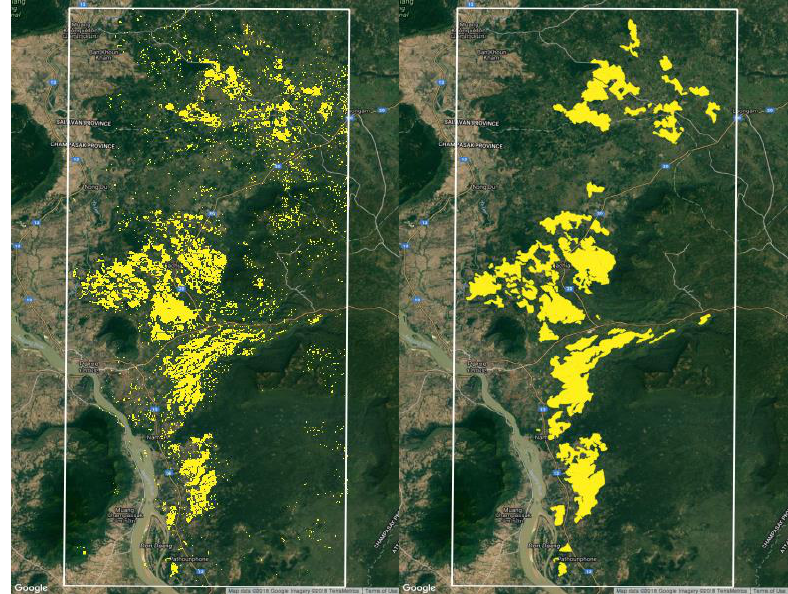
Figure 4. Rubber planted areas in southern Laos mapped from satellite data. The map on the left was produced by hand digitizing the plantation boundaries using visual clues while the map on the right was produced by supervised image classification.